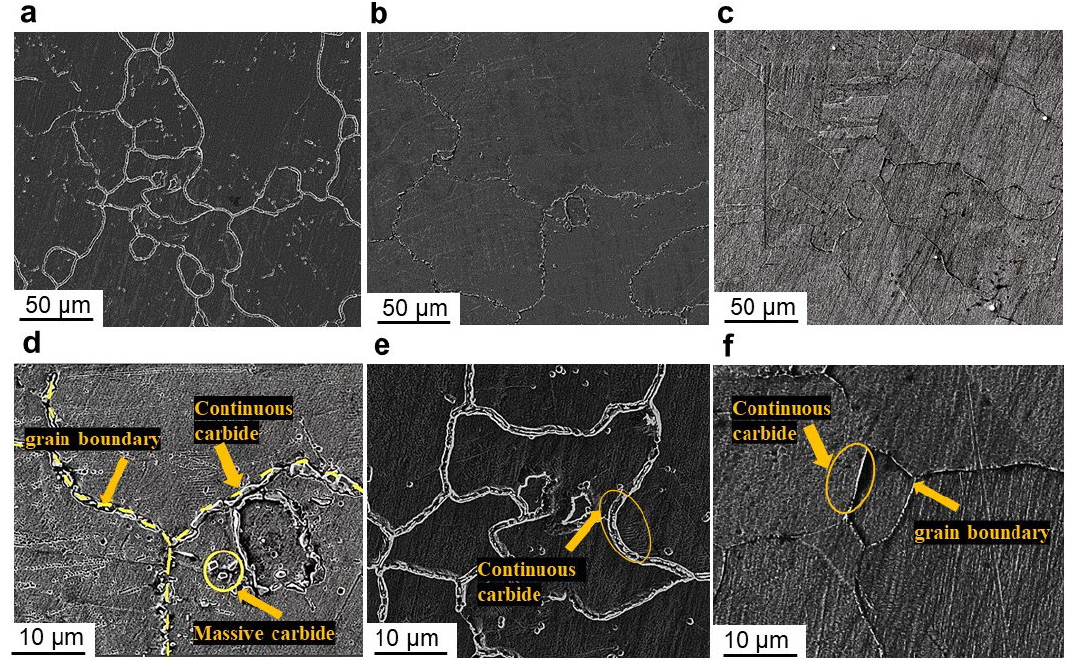
Figure 5. Microstructure characterization of HT samples by using low-magnification and high-magnification secondary electron images (SEM): ( a , d ) 1175-FC; ( b , e ) 1175-AC; ( c , f ) 1175-WQ.